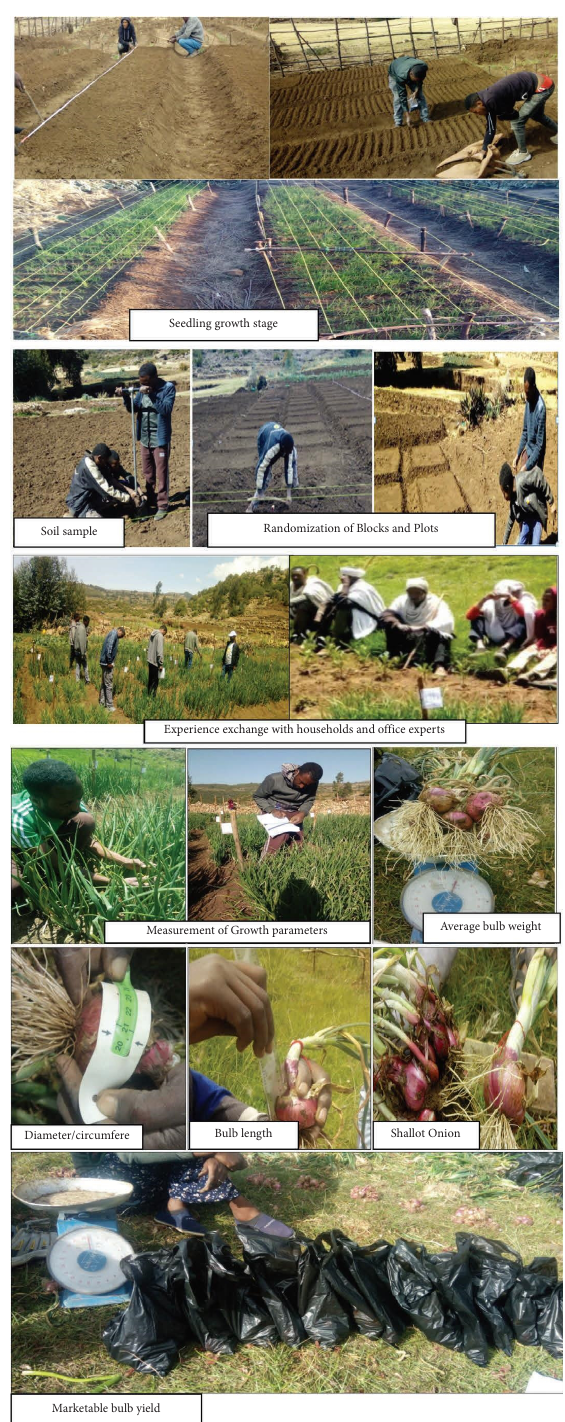
Figure 3: Photos of the experimental